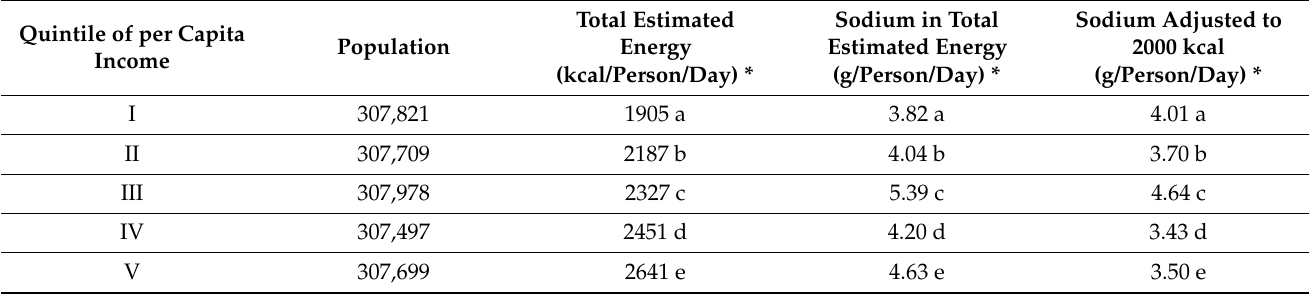
Table 2. Energy and sodium availability for household consumption based on food purchases by increasing quintiles of income distribution in Costa Rica,